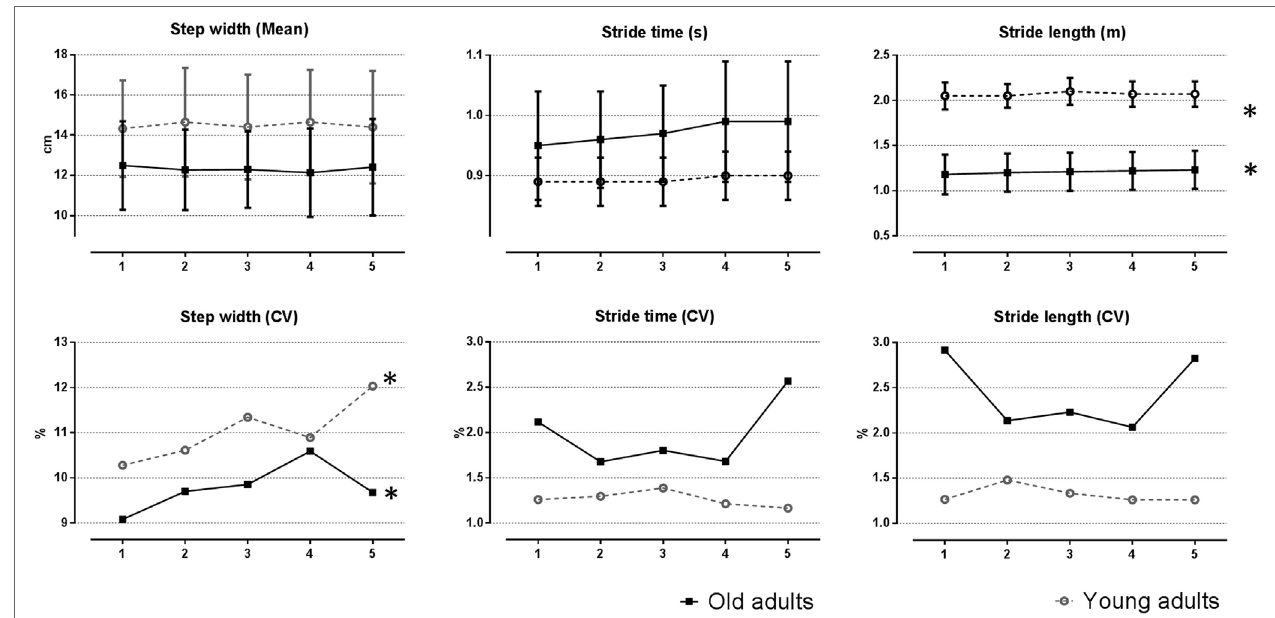
FigUre 1 | Temporospatial parameters during fast-walking activity at the top. The mean and SD for each subject were subsequently averaged across subjects within the age-group. At the bottom, differences in the coefficient of variation revealed the differences in temporospatial variability along the task. *Indicates statistically significant time